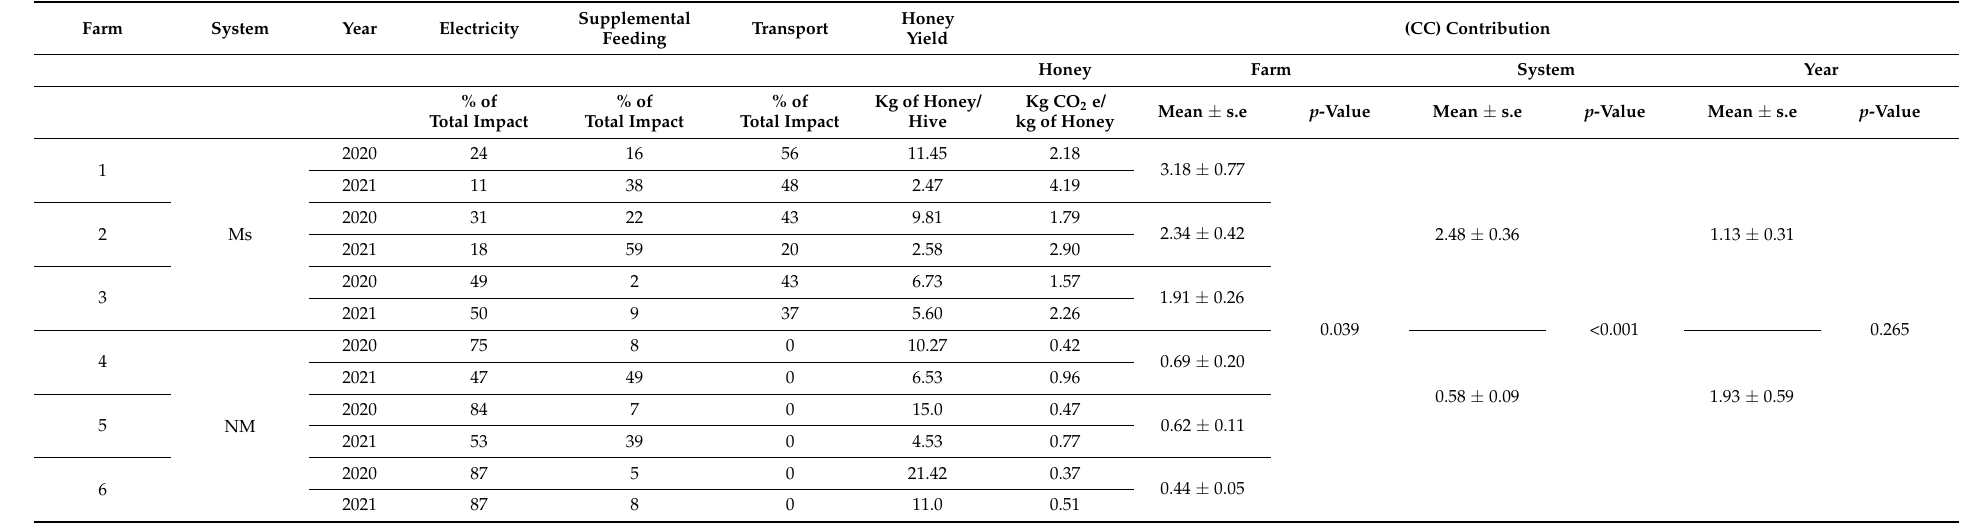
Table 3. Contributions to climate change (main impact and total) of honey production in the 2 years of